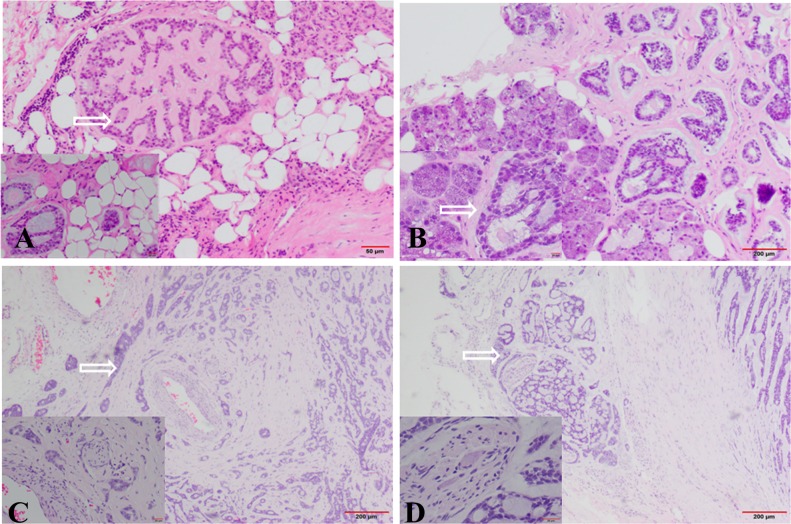
SACC collective cells invaded into normal tissues under light microscopy with H&E staining.(A) Arrow showed invasion into fat tissue (HE×200; ×400). (B) Arrow showed invasion into gland (HE×200; ×400). (C) Arrow showed invasion into blood vessel (HE×200; ×400). (D) Arrow showed invasion into nerve tissue (HE×200; ×400). The invasive cells were aggregated or clustered, and not single cells.